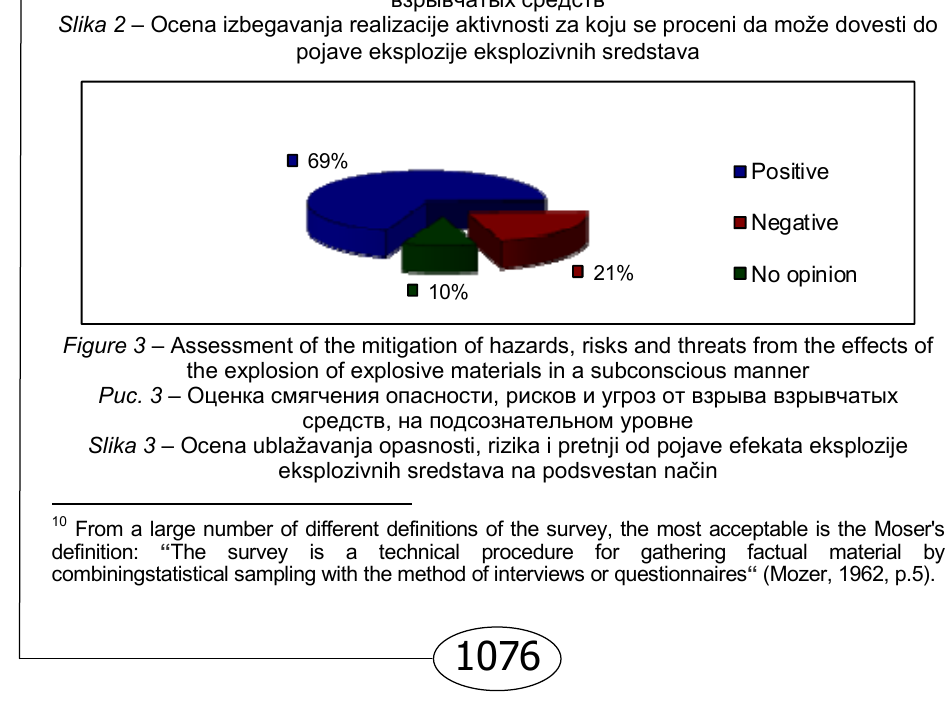
Рис . 2 – Оценка прекращениядеятельности , которая может привести к взрыву